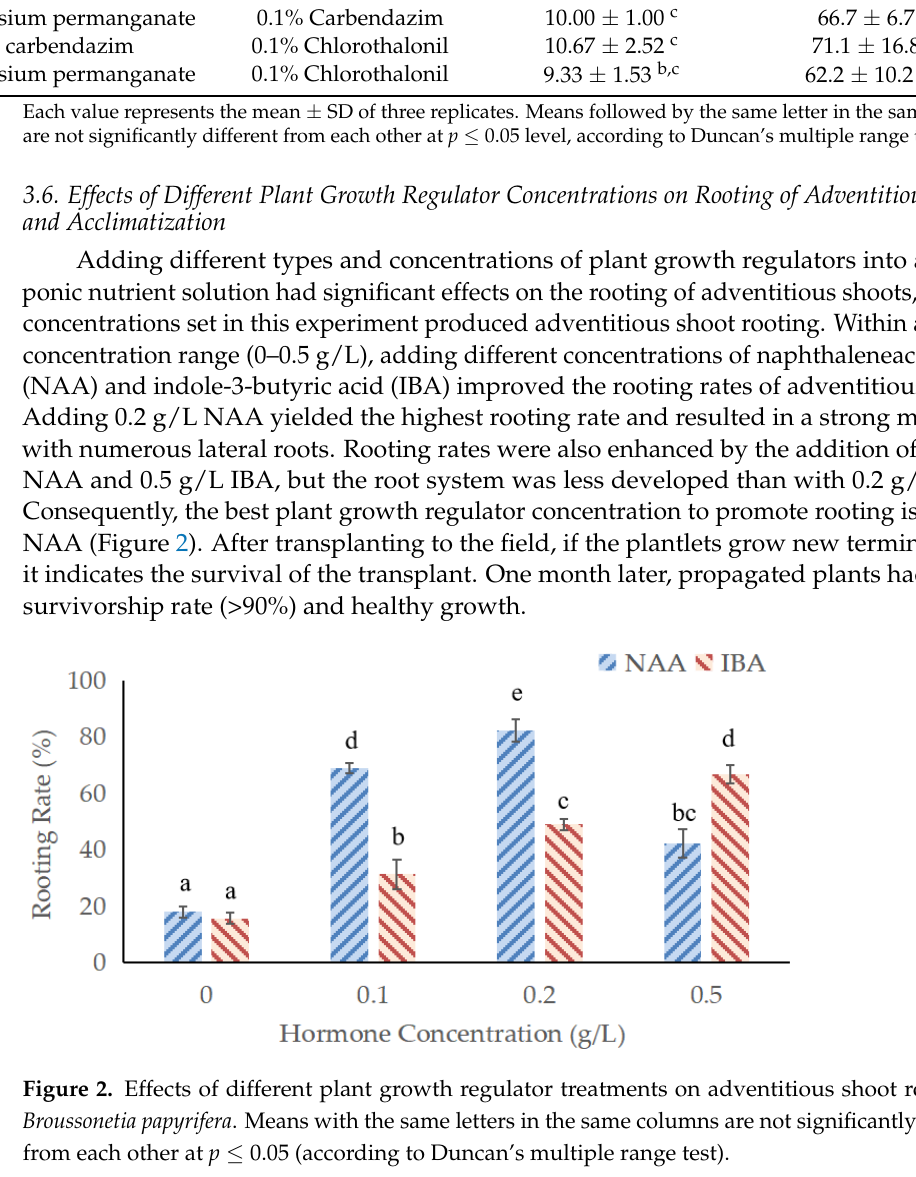
Table 8. Effects of different disinfection combinations on root propagation induction rate.